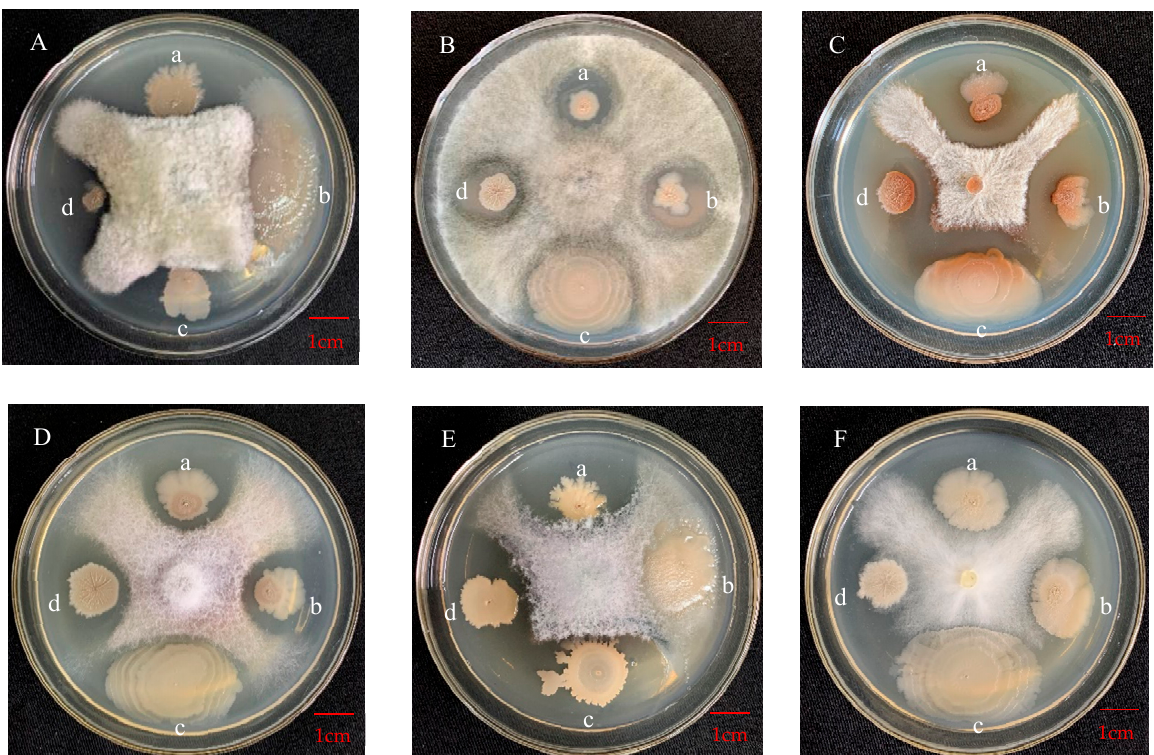
Figure 3. Inhibition of apple endophytic bacteria to apple disease pathogens. ( A ): Alternaria alternata .